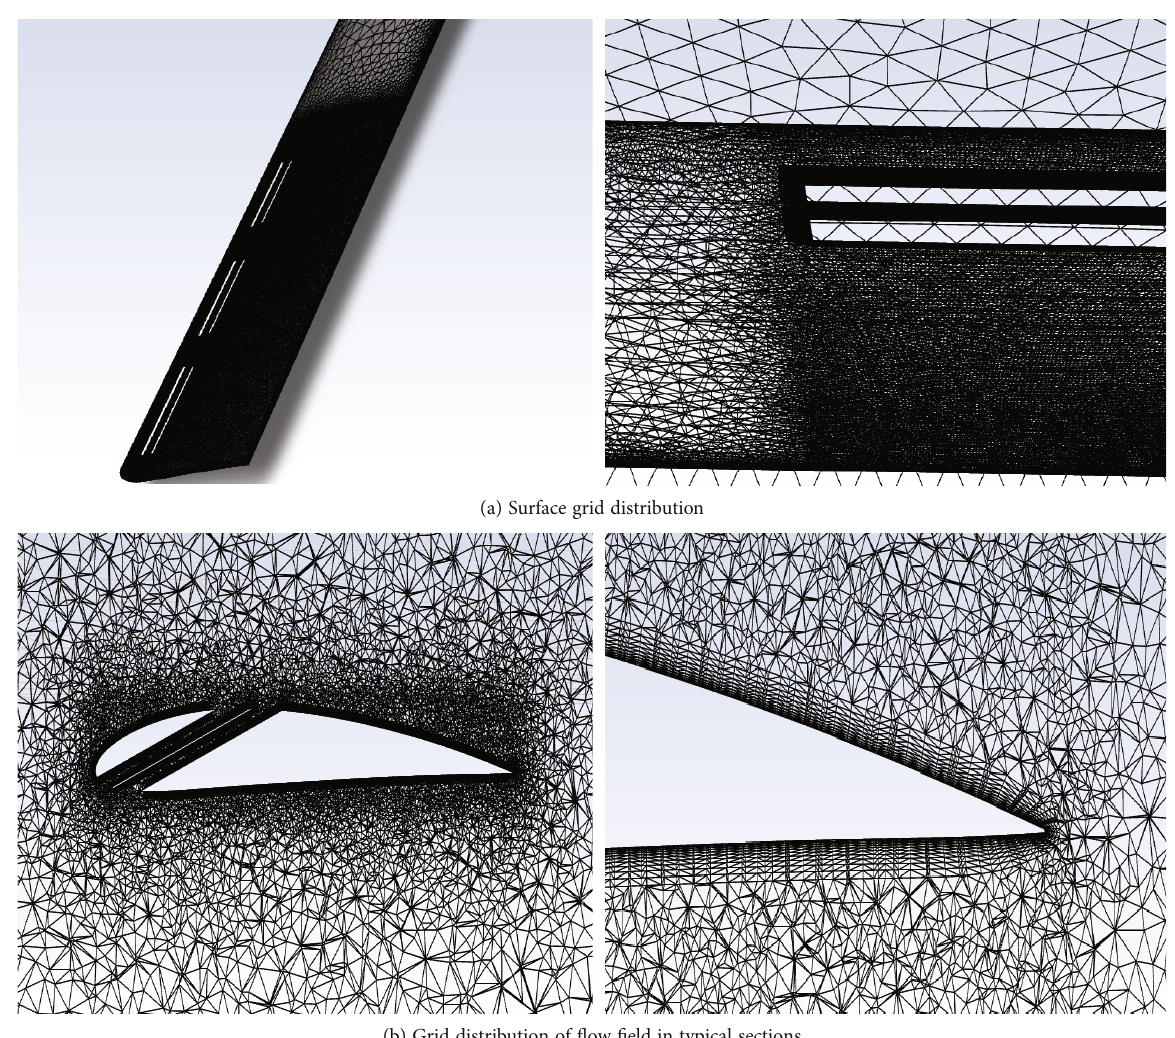
Figure 4: Computational domain grid of grid fusion lifting surface with the diversion angle of 20 ° and grid number of